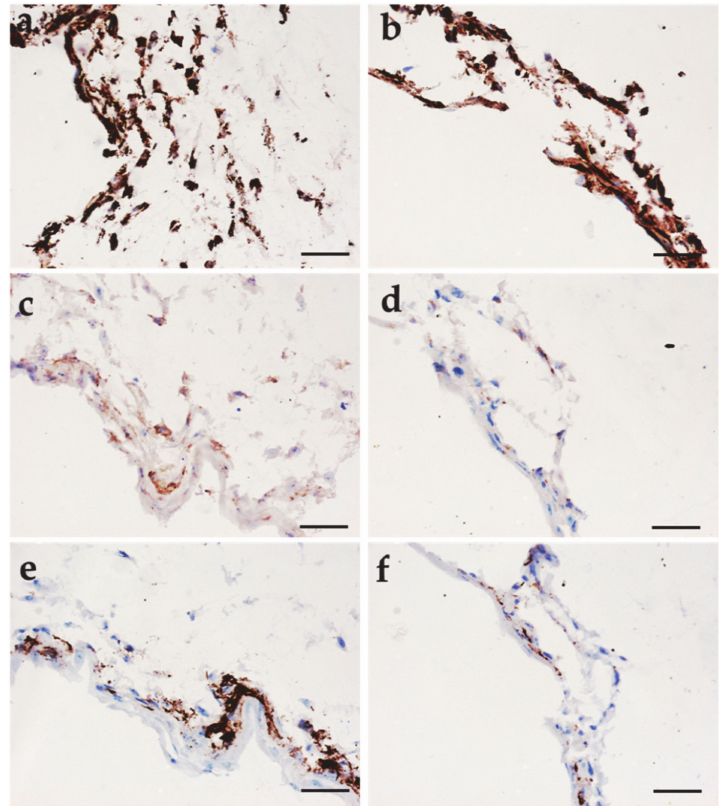
Figure 6. Immunohistochemical analysis of hMSC / *PCL constructs revealing the expression of collagen types I ( a , b ), III ( c , d ), and IV ( e , f ). Immunopositivity is in brown and cell nuclei are in violet: ( a , c , e ) constructs di ff erentiated in static conditions; ( b , d , f ) construct di ff erentiated in dynamic conditions. Scale bar is 50 µ m; original magnification 400 ×